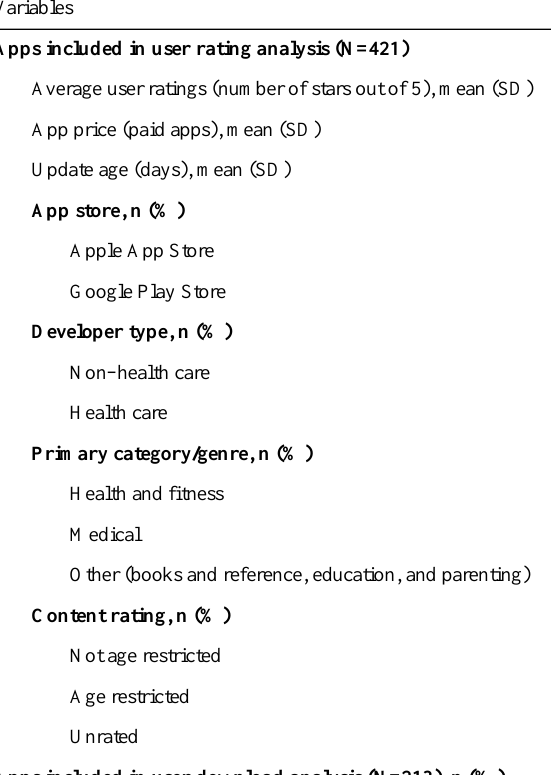
Table 2. Descriptive statistics for independent and dependent variables.